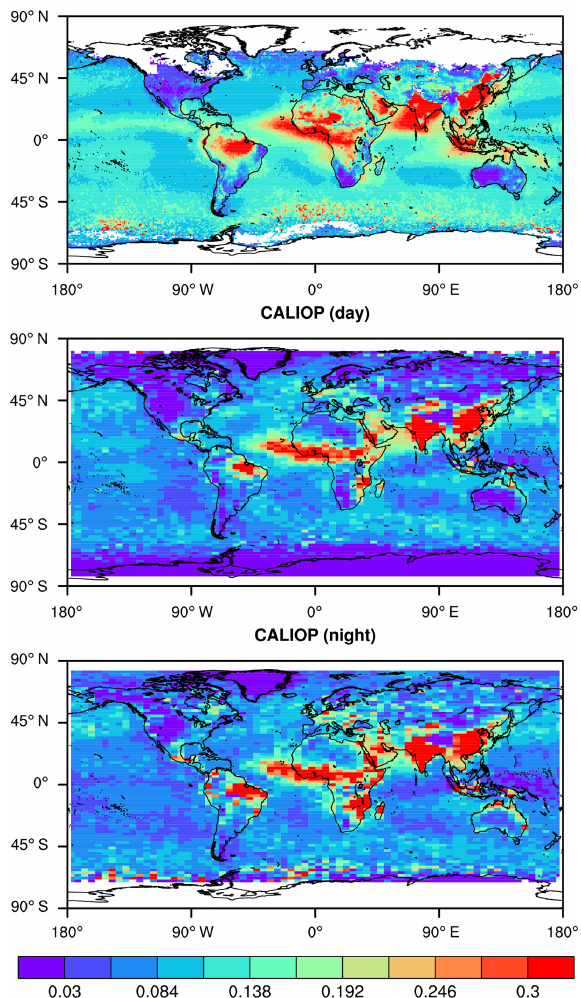
Figure 12. Spatial distributions of the monthly mean MODIS Aqua AOTs at 550nm, as well as daytime CALIOP and nighttime CALIOP AOTs at 532nm in November from 2006 to